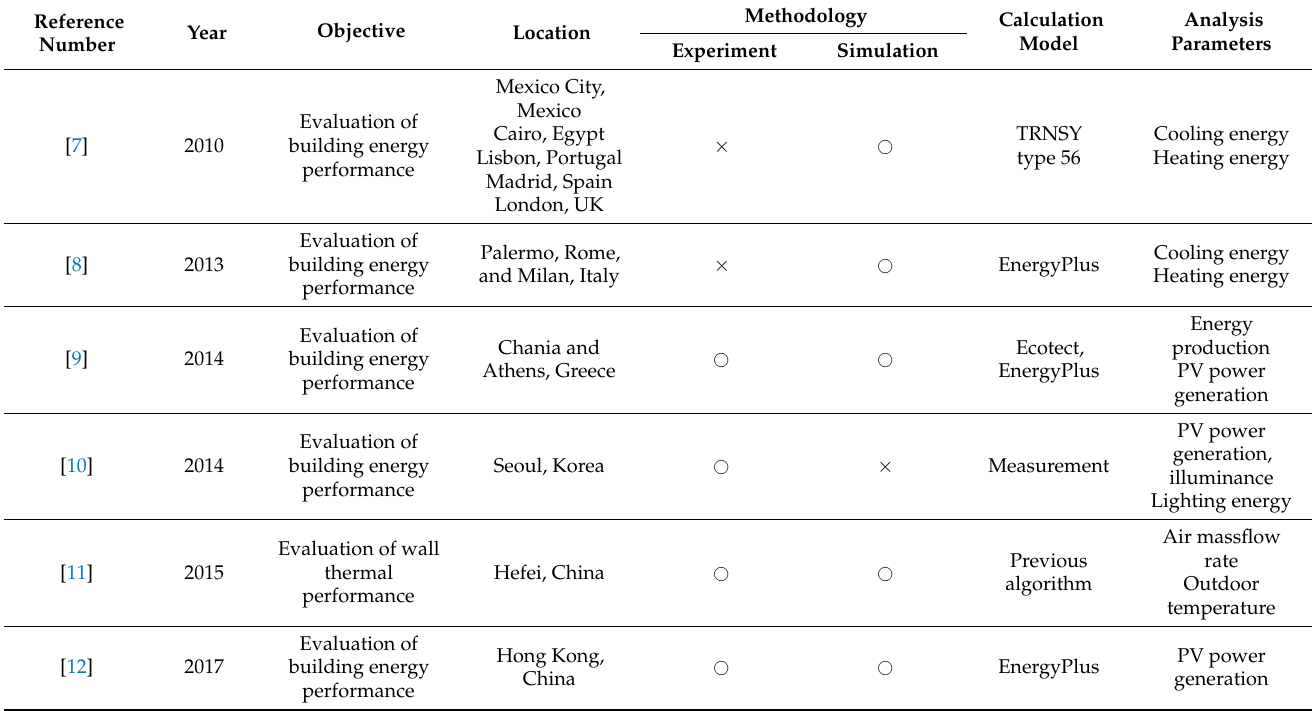
Table 1. Literature related to various shading